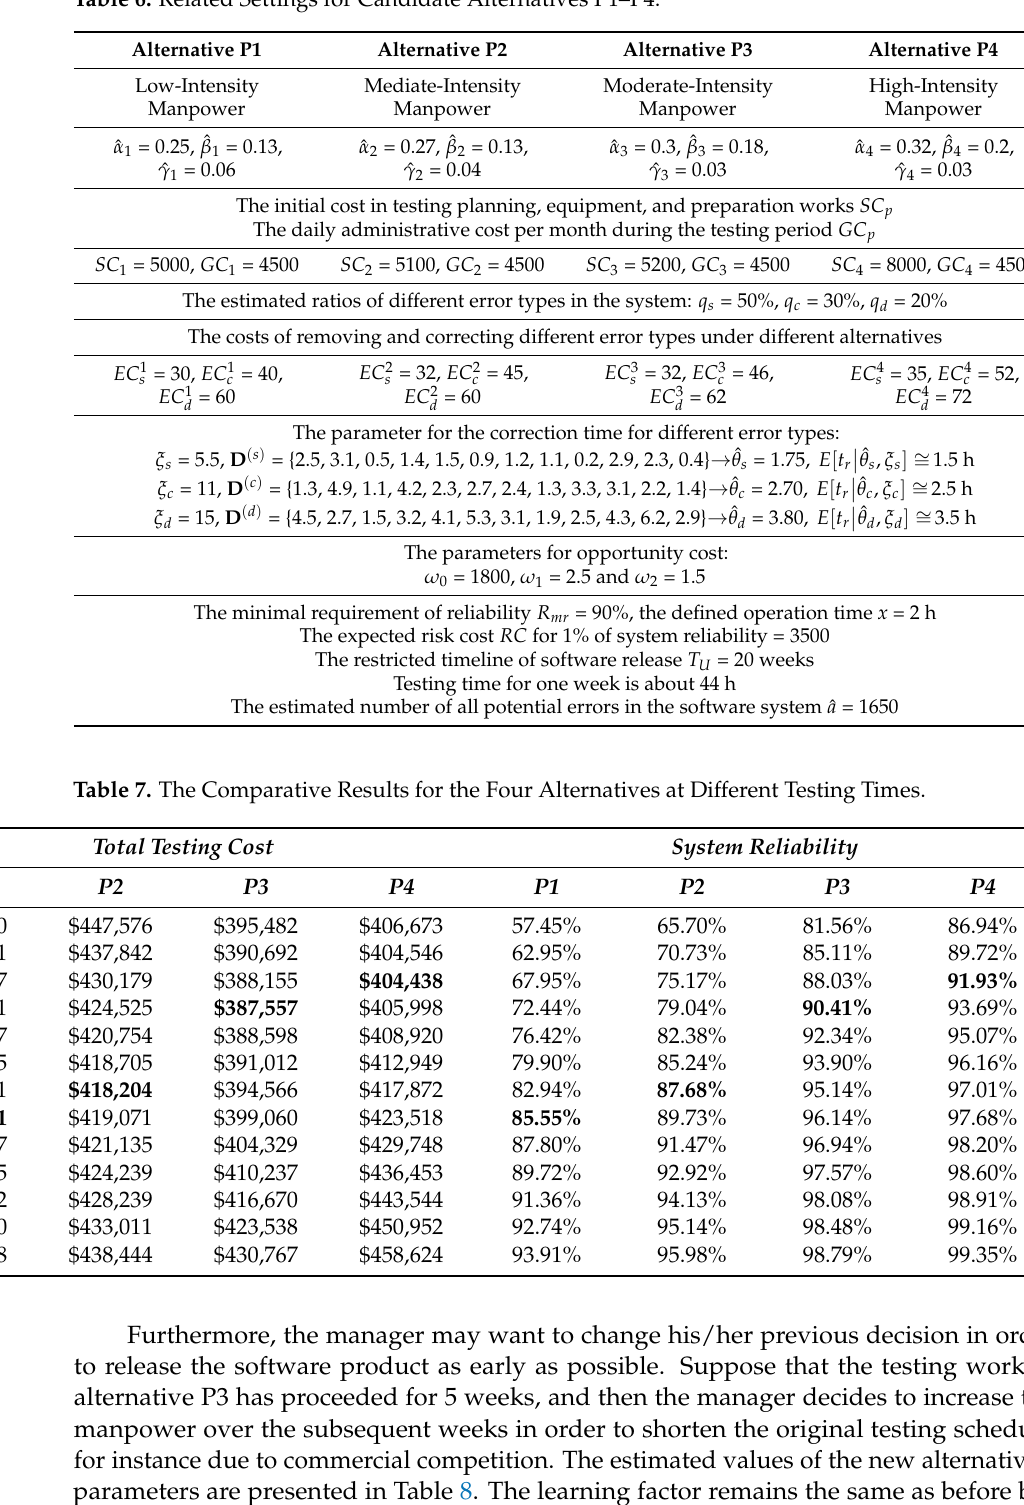
Table 6. Related Settings for Candidate Alternatives P1–P4.